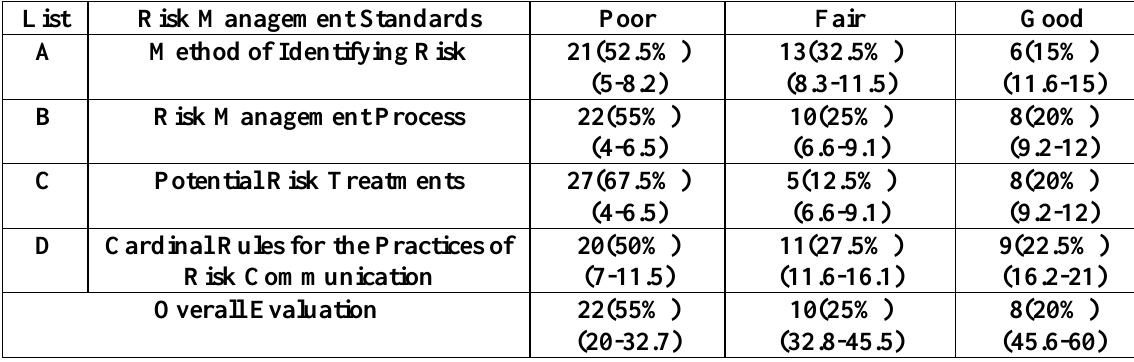
Table (4): Mean of Scores on Items of Risk Management at Ordinary Primary Health Care Centers